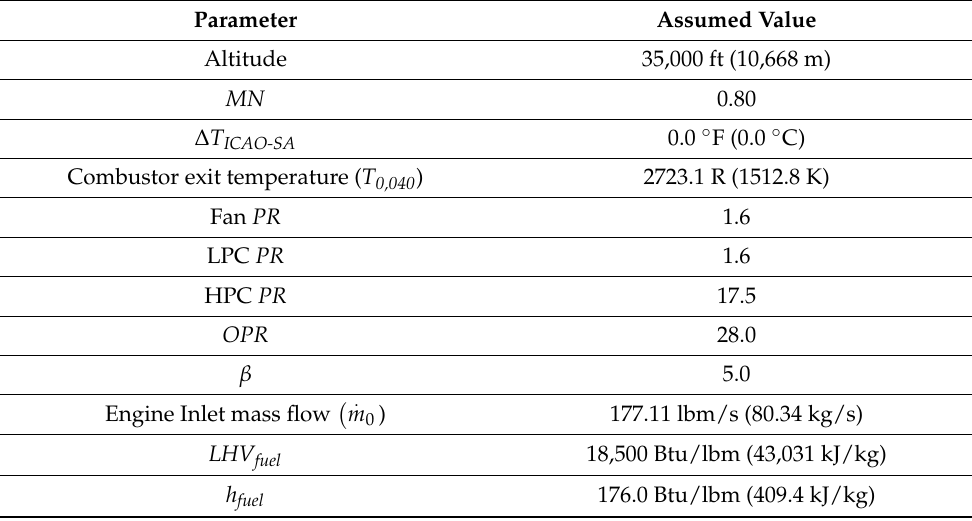
Table 1. Top of Climb (TOC) assumptions.